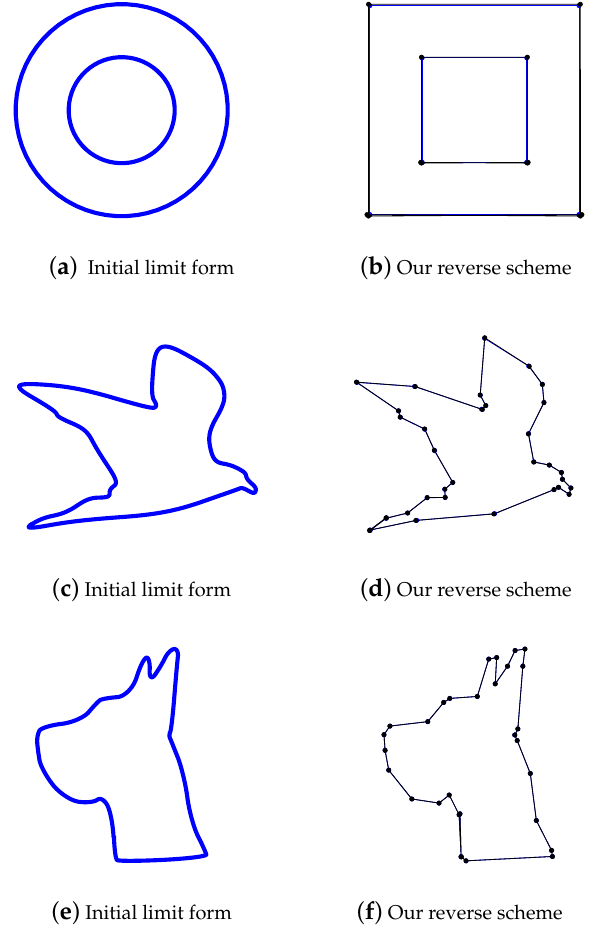
Figure 4. The generalized reverse scheme of order